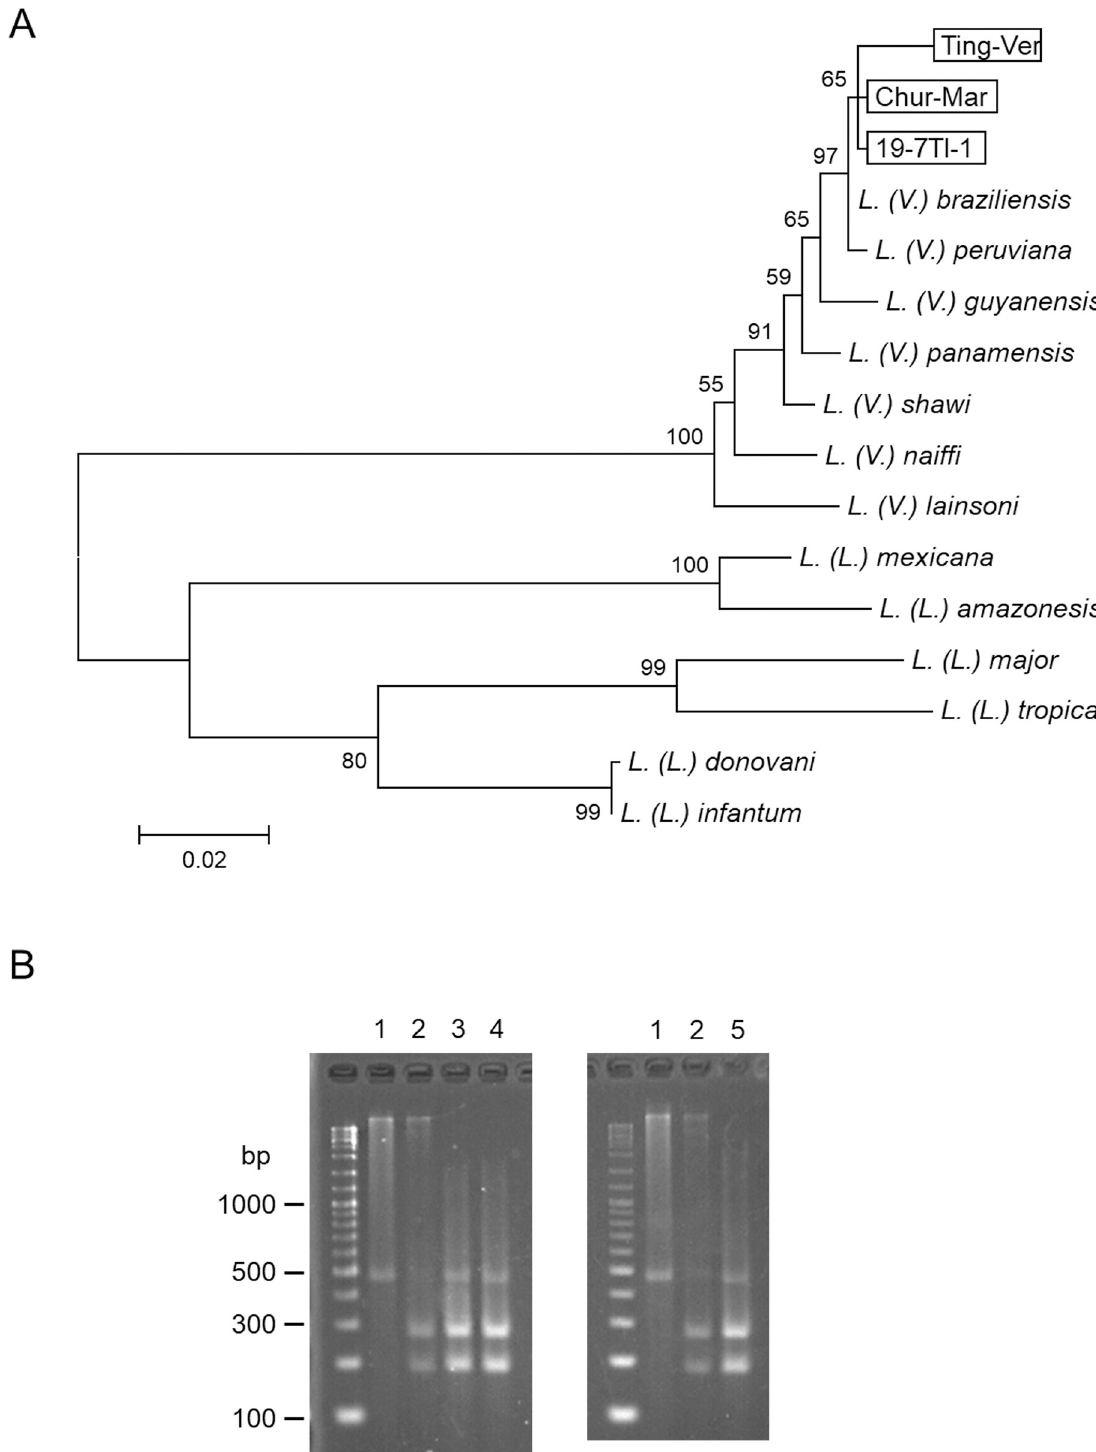
Fig 3. Identification of Leishmania species by cytochrome b and mannose phosphate isomerase gene analyses. A. A phylogenetic analysis of cytochrome b gene was performed by the maximum likelihood method together with sequences from 13 Leishmania species. The scale bar represents 0.02% divergence. Bootstrap values are shown above or below branches. Ting-Ver: Leishmania -positive Pi . verrucarum from Tingo Bajo, Chur-Mar: Leishmania -positive Pi . maranonensis from Nuevo Churuja, 19-7TI-1: a patient’s specimen from Tingo Bajo. B. PCR-RFLP analysis of mannose phosphate isomerase genes from L . (V . ) braziliensis (lane 1), L . (V . ) peruviana (lane